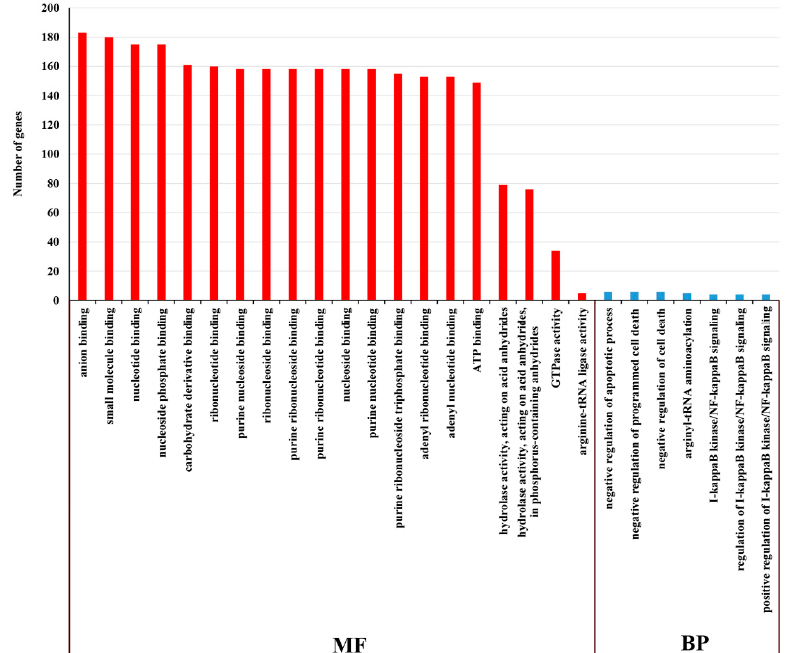
Figure 11. GO analysis of lncRNA in the cultivar “Huoche” under heat stress. The histogram of GO enrichment analysis of the targeted mRNA of DE lncRNAs. The ordinate is the enriched GO term, and the abscissa is the number of differentially expressed genes in this term. Different colors are used to distinguish biological processes, cellular components and molecular functions.